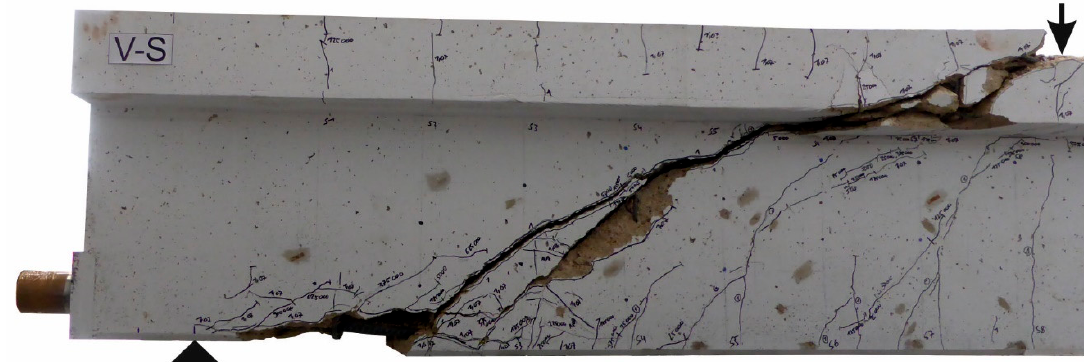
Figure 3. Crack pattern in the web and upper flange after failure (test specimen T-33-2, first part of test).